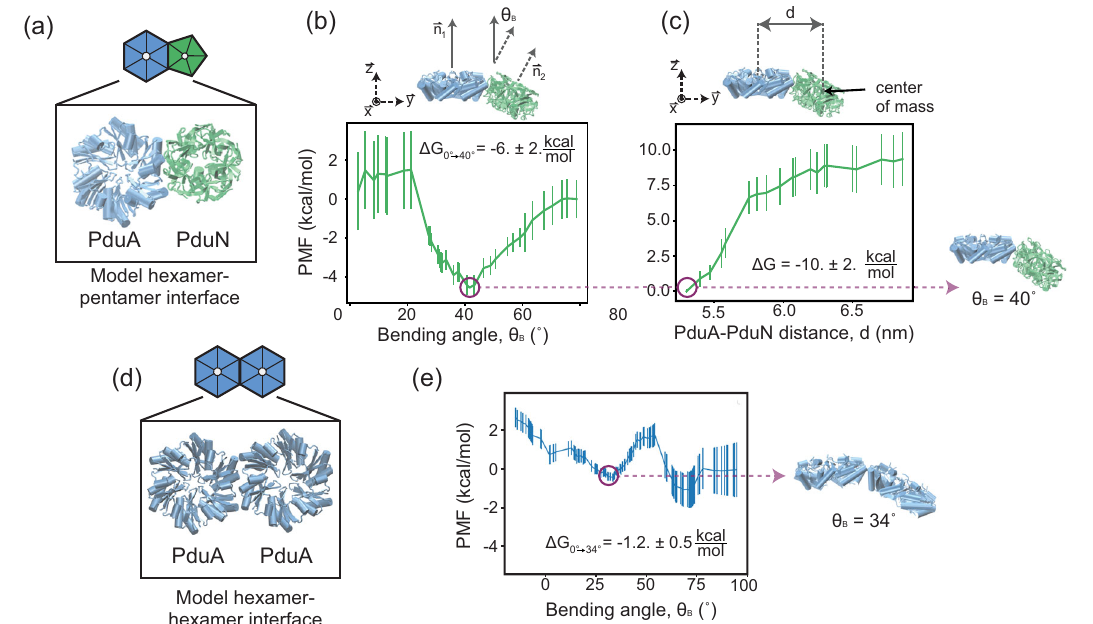
Fig. 3 Analysis of the molecular interactions responsible for PduN incorporation into the shell using all-atom molecular dynamics (AAMD) simulations. a Schematic of the PduA-PduN interface used for these simulations, where PduA is shown in blue and PduN is shown in green. b Potential of mean force (PMF) calculated from AAMD simulations as a function of bending angle, Θ B, between PduA and PduN. Δ G 0° → 40° is the difference in the PMF between the 0° and 40° bending angles. c PMF calculated from AAMD simulations as a function of the distance between PduA and PduN, used to calculate the total interaction energy ( Δ G) between these two oligomers. d Schematic of the PduA-PduA interface used for these simulations. e PMF calculated from AAMD simulations as a function of bending angle, Θ B, between two PduA hexamers. Δ G 0° → 34° is the difference in the PMF between the 0° and 34° bending angles. Calculations used calculate data points in ( b ), ( c ), and ( e ) are described in Supplementary Method 1. Error bars on plots in ( b ), ( c ), and ( e ) represent the sampling error on the calculated energies, estimated by splitting simulation data into different sections and observing the differences in the calculated potential as described in Supplementary Method 1, Calculation speci fi cs. Source data for plots ( b ), ( c ), and ( e ) are provided as a Source Data fi